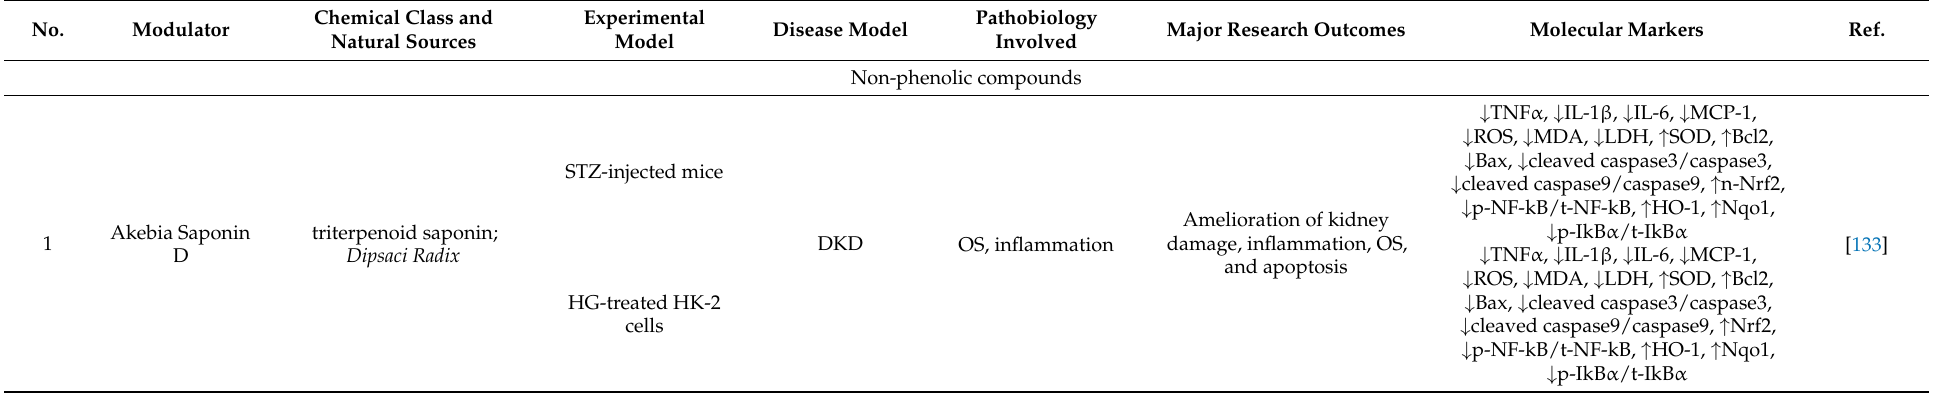
Table 2. Kidney protective effects provided by non-phenolic compounds of phytochemicals targeting the Nrf2-HO-1 signaling